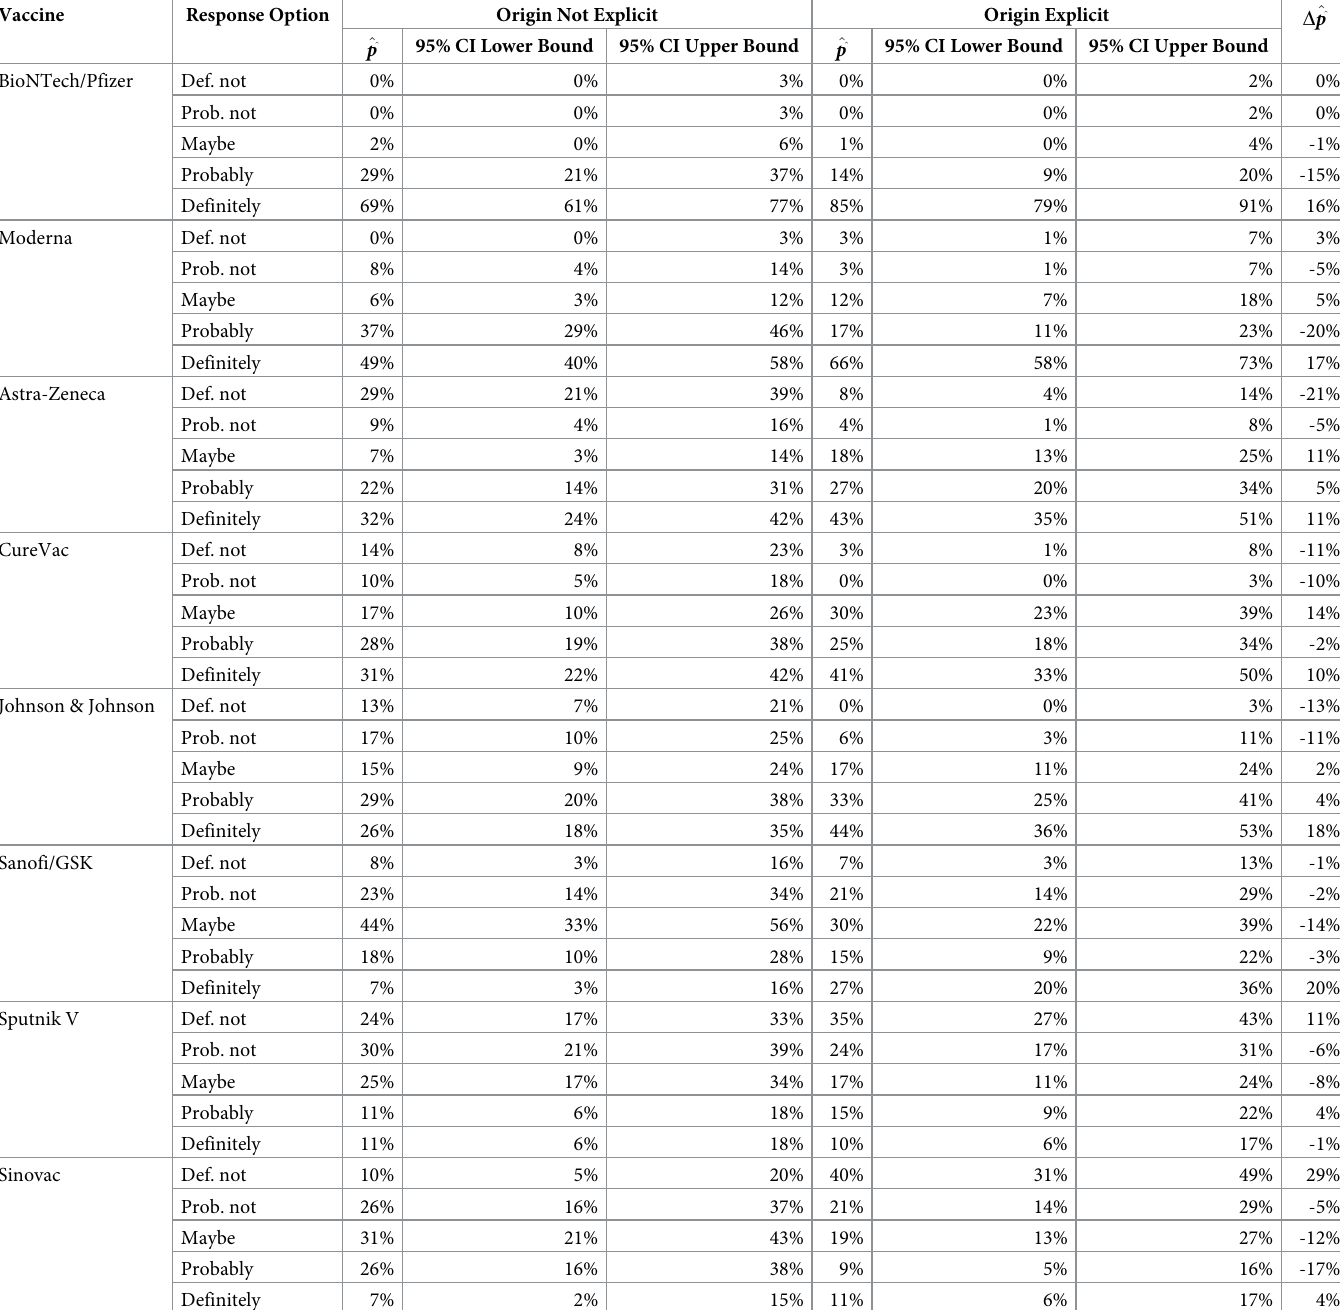
Table 3. Summary of proportions for each group per COVID-19 vaccine, as well as the difference for each response option. Vaccine Response